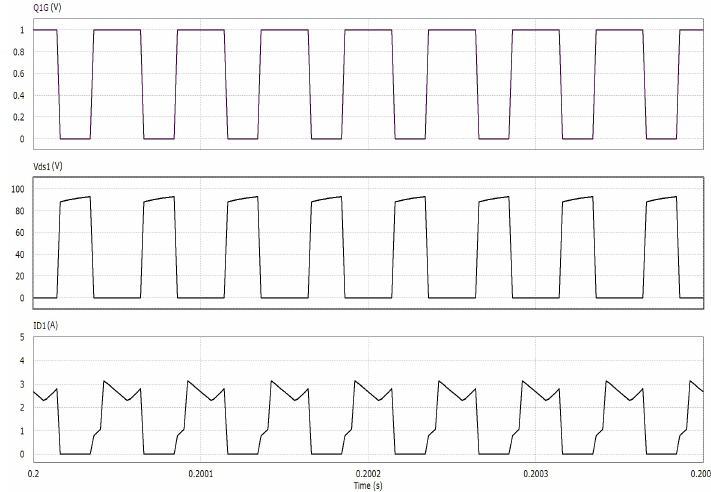
Figure 15. PSIM simulation of switch stresses of Q1.